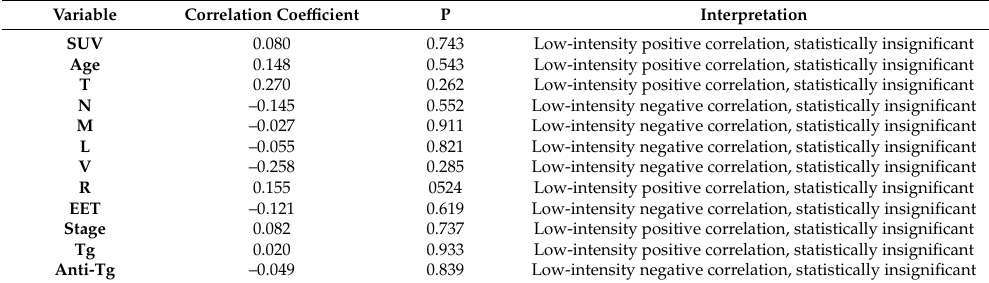
Table 3. Analysis of the correlation between BRAF status and the prognostic